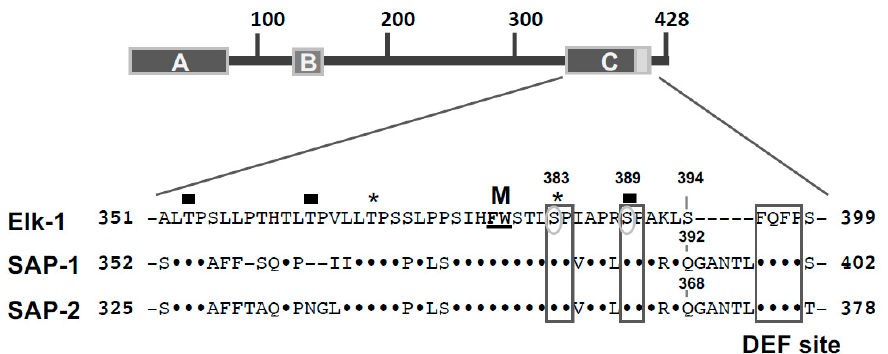
Figure 6. Phosphorylation sites within the activation domain of TCF proteins. Amino acid sequence of the transcriptional activation domains (C-box) of Elk-1, SAP-1 and SAP-2. The key phosphorylation sites S383 and S389 are highlighted. Rapid (stars) and intermediate phosphorylation sites (bars) are indicated. On the C-terminal end of the C-box is the second MAP kinase docking site (DEF site). In addition, the Med23 binding site (F378, W379) is shown (M). The sequence information is derived from Ref. [7].